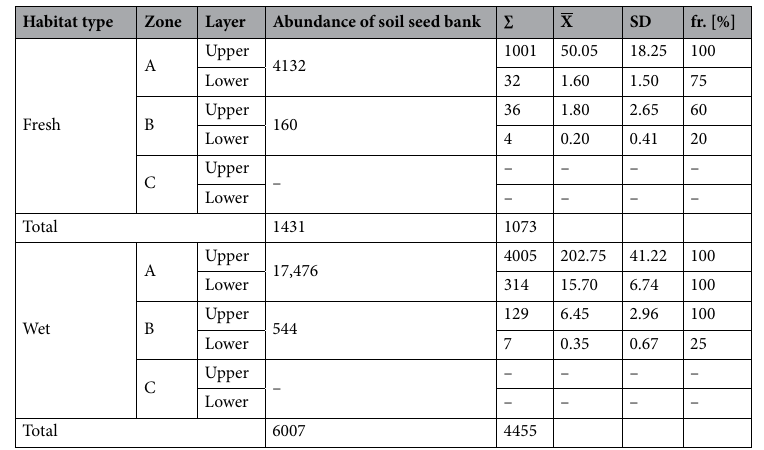
Table 5. The abundance of Rudbeckia laciniata soil seed bank in studied zones. A invasion zone, B transition zone, C control zone, upper layer of soil 0–5 cm, lower layer of soil 5–10 cm; Abundance of the seed bank— number of seeds R. laciniata /m 2 , ∑ total number of seedlings, X mean number of seedlings in a sample, SD standard deviation, fr frequency (percentage of pots with seedlings per 20